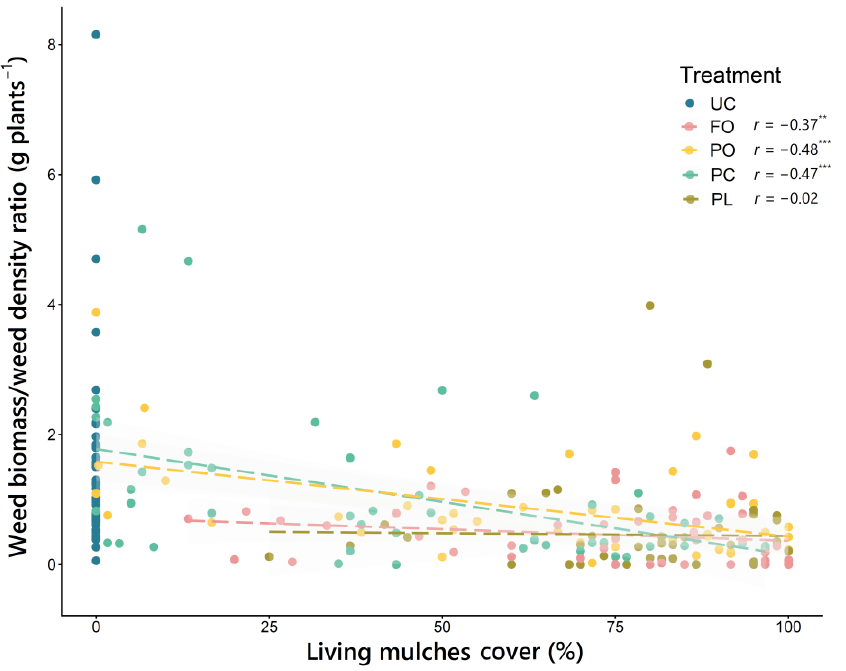
Figure 5. Correlation between living mulch cover (%) and weed biomass/weed density ratio (g plants − 1 ) according to the factor “treatment”. Spearman’s correlation coefficient ( r ) and significance level (no asterisks, non-significant; ** p < 0.01; *** p < 0.001) are indicated for each of the estimated correlations. UC, untreated control; FO, Festuca ovina living mulch; PO, Pilosella officinarum living mulch; PC, Plantago coronopus living mulch; PL, Plantago lanceolata living mulch.